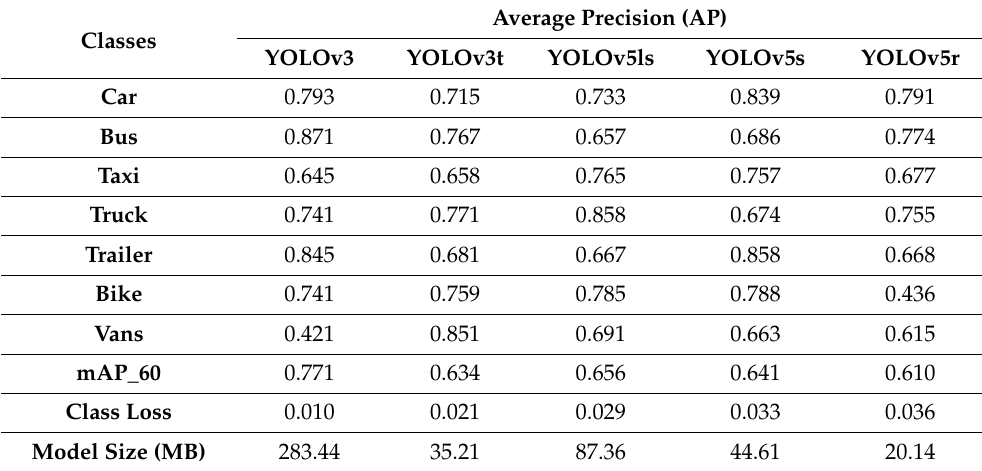
Table 6. Performance characteristics of YOLO networks training on previous SR1 sets, applied fine-tuning on SR2 with data evaluation and validation on SR2